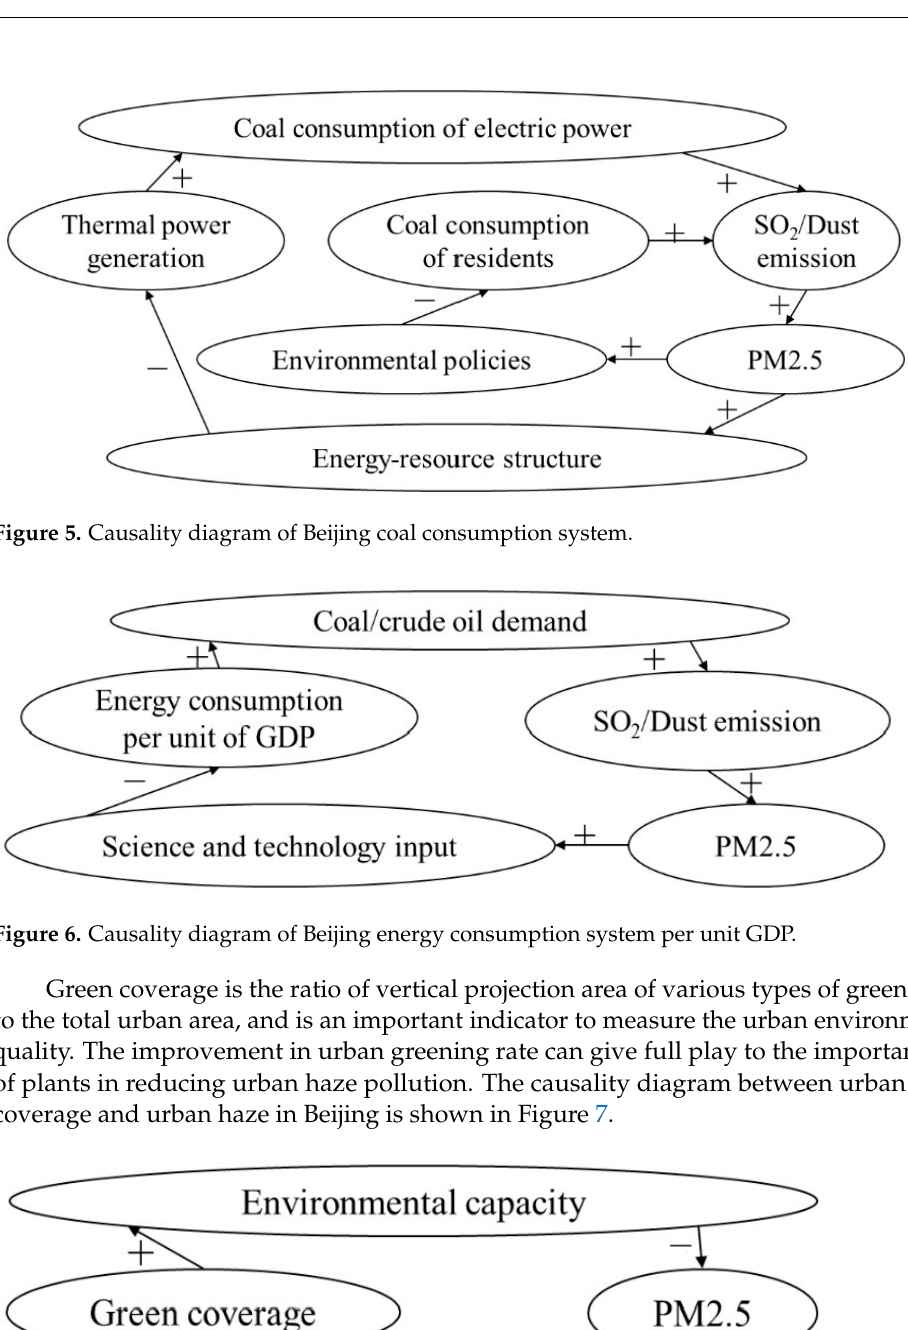
coverage and urban haze in Beijing is shown in Figure 7.